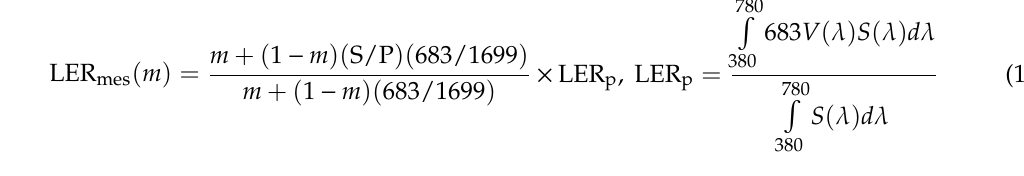
Table 4. Information of optimal spectra.